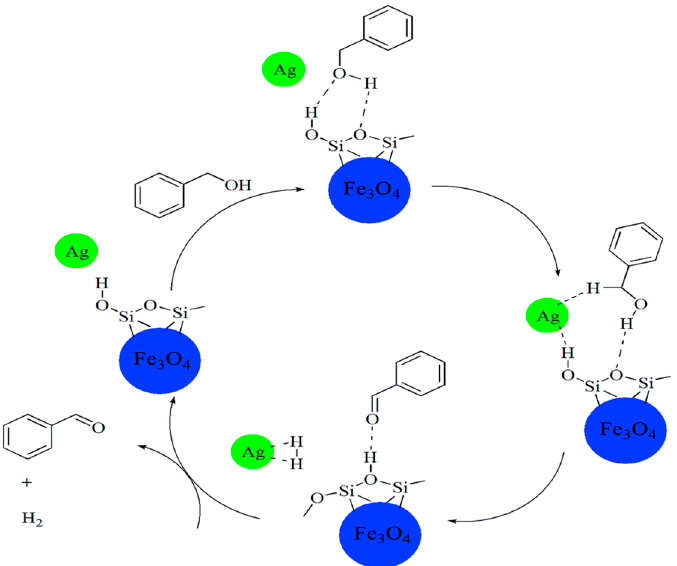
Figure 16. Mechanism of benzyl alcohol dehydrogenation by Fe 3 O 4 @SiO 2 -Ag catalyst. Reprinted with permission from reference [131]. Copyright 2014 Asian Publication Corporation.